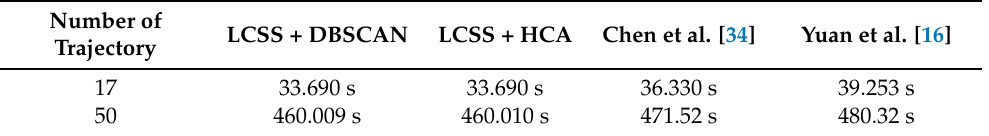
Table 3. Time consumption of